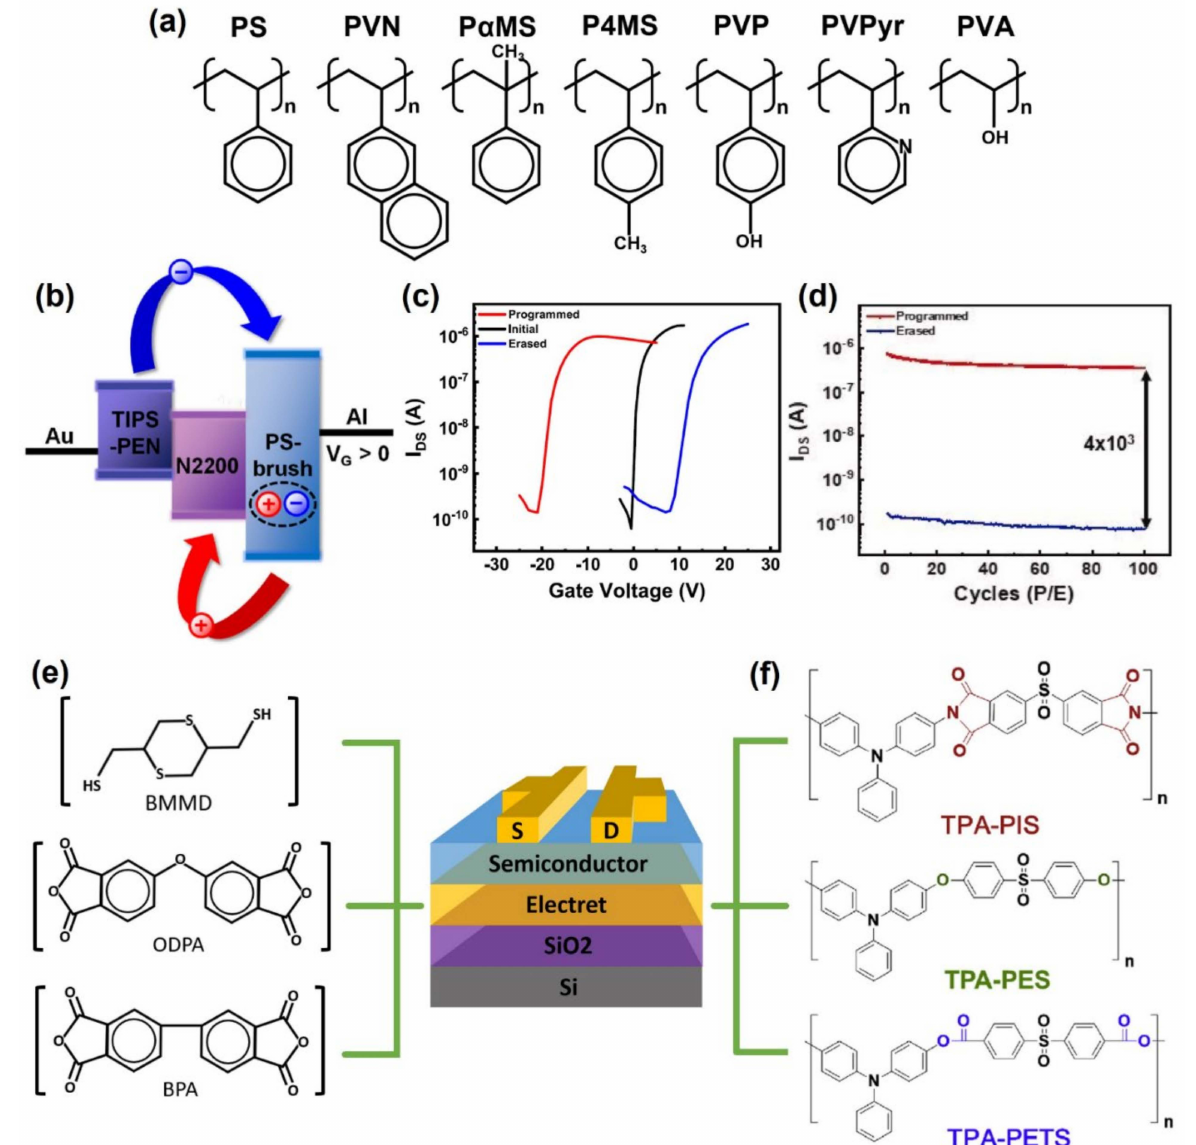
Figure 3. ( a ) Styline-based polymer electret materials; PS, PVN, PaMS, P4MS, PVP, PVPy, and PVA (adapted from [55] with permission from John Wiley and Son). ( b ) Mechanism, ( c ) current–voltage curve, ( d ) retention properties of polymer electret memory using styrene-based (polystyrene-brush) PS-brush electret(adapted from [56] with permission from Elsevier). Schematic configuration of the OFET memory device and chemical structures of the polymer electret layers: ( e ) PITE(BMI- BMMD), PI(APS-BPA), PI(APS-ODPA)) (adapted from [21] with permission from John Wiley and Son) ( f ) TPA-PIS, TPA-PES, and TPA-PET (adapted from [57] with permission from